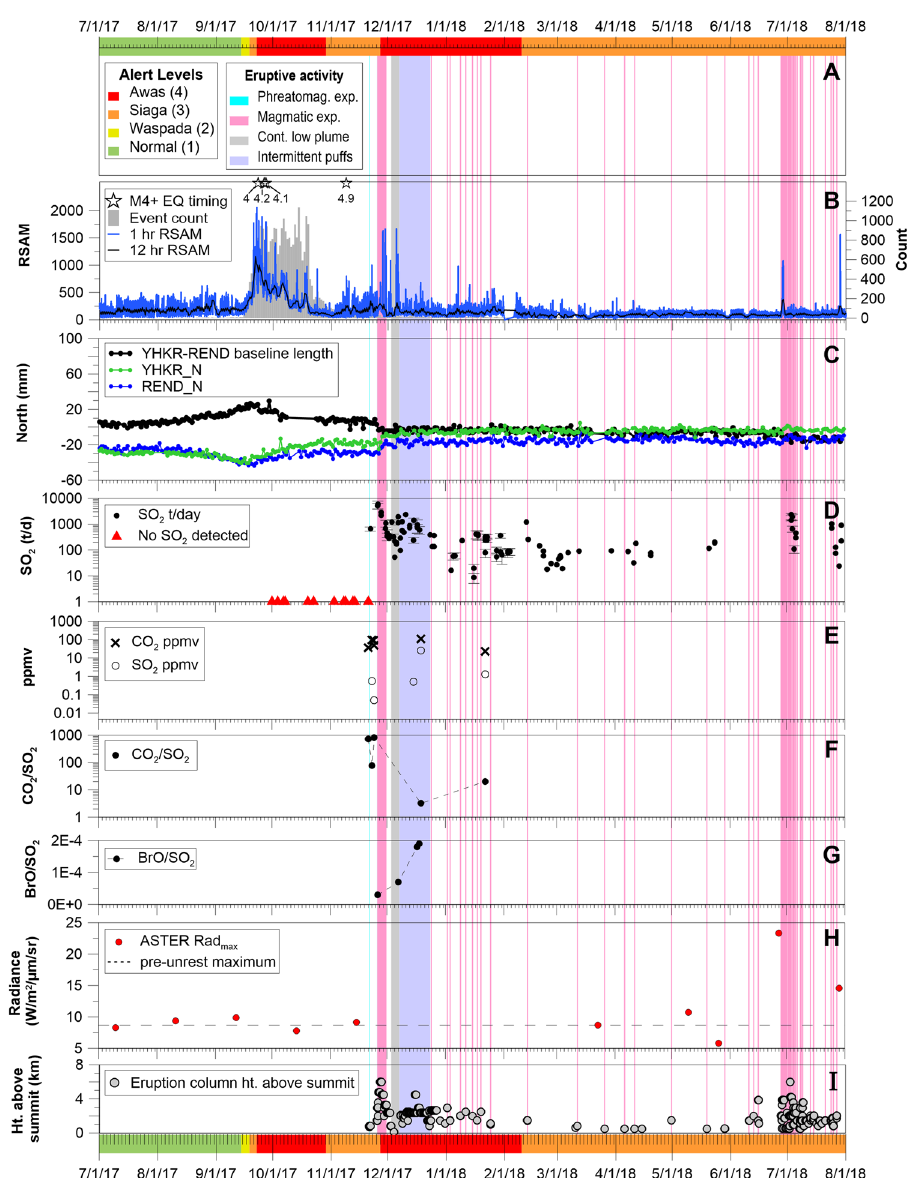
Figure 2. The timeline of the 2017–2018 unrest and eruption at Mount Agung, showing (from top to bottom) ( A ) Alert level changes; ( B ) RSAM from TMKS, and daily seismic event counts. Magnitude ≥ 4 earthquake times are displayed as labelled stars across the top of the panel. Note: the RSAM peak in late July 2018 is related to the large (M6.4) tectonic events near the island of Lombok; ( C ) GNSS displacements and baseline length between YHKR and REND (also known as RNDG) stations; ( D ) SO 2 emission rates from ground-based mobile DOAS; (E ) CO 2 and SO 2 mixing ratios above ambient background from drone-transported Multi-GAS; ( F ) CO 2 /SO 2 ratios (molar) from Multi-GAS; ( G ) BrO/SO 2 ratio from mobile DOAS; ( H ) Advanced Spaceborne Thermal Emission and Reflection Radiometer (ASTER) maximum radiance values from the crater, with pre- unrest maximum radiance (8.7 W/m 2 / μ m/sr) plotted as dashed line (see also Supplemental Figures Fig. S1); and ( I ) eruption column heights (as measured above the 3.142 km summit). Running across the entire graph are phreatomagmatic (blue) and magmatic (pink) explosions, as well as periods of continuous ash venting (grey) and intermittent ash puffing